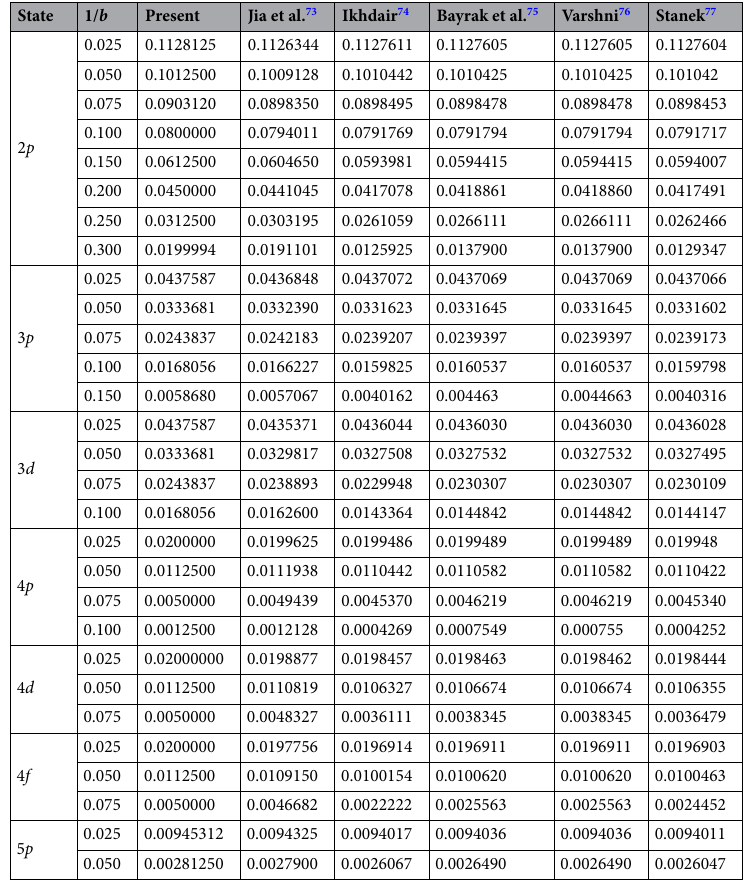
E nl ) for Hulthen potential as a function of the screening parameter